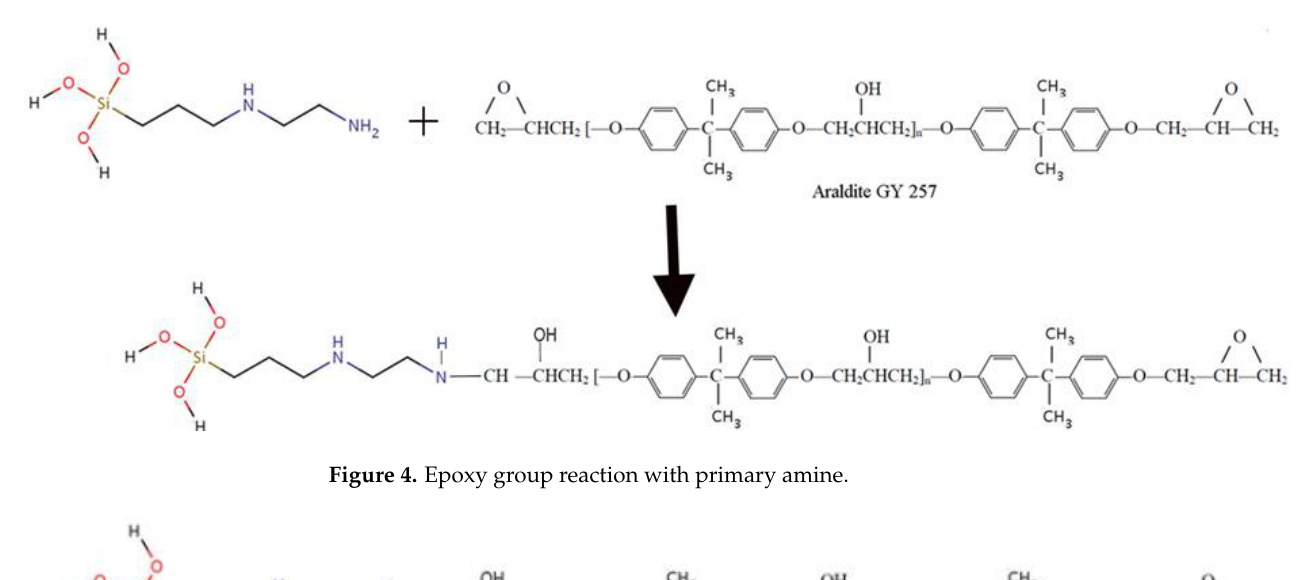
Figure 3. Hydrolysis of ORMOSIL.